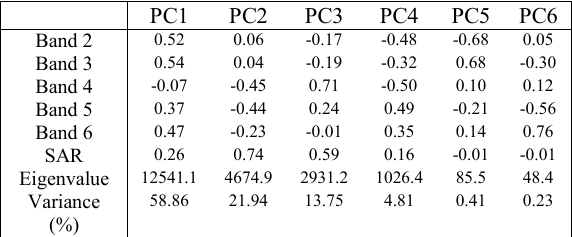
Table 1. PC coefficients from Landsat 8 and Sentinel 1A